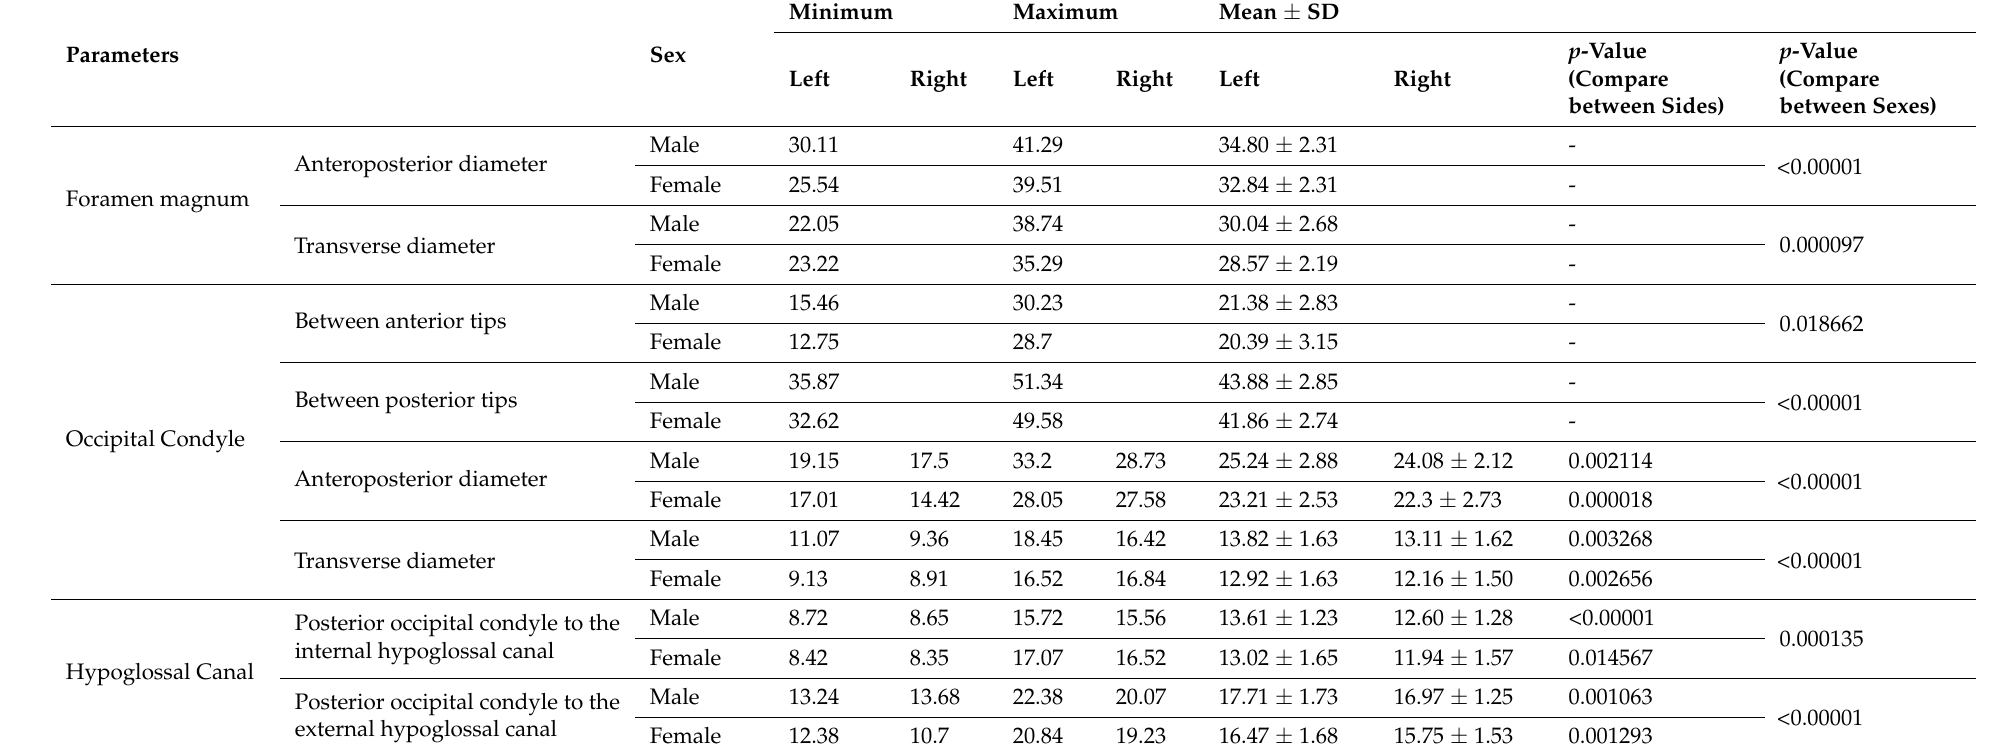
Table 1. Morphometric measurements related to the foramen magnum, occipital condyle, and hypoglossal